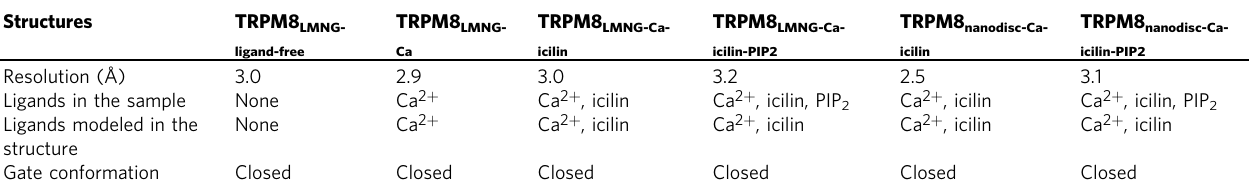
Table 1 Major information of six MmTRPM8 structures reported in this